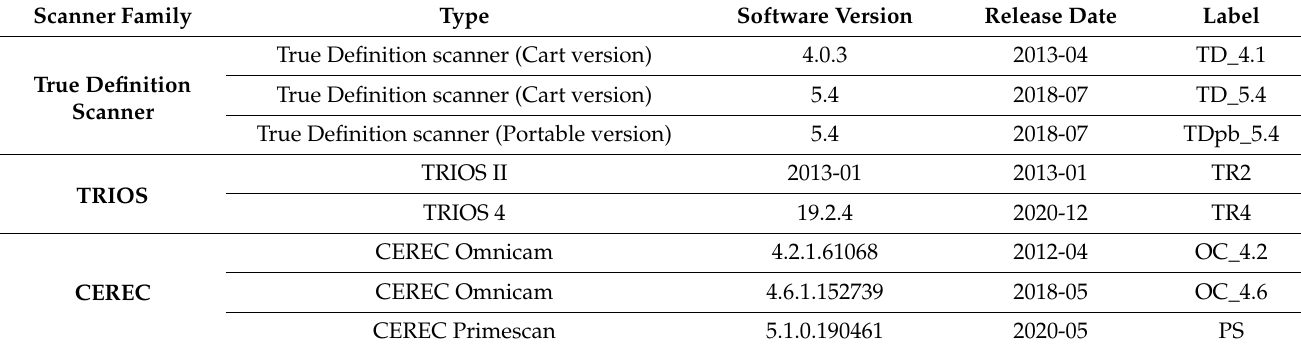
Table 1. Intraoral scanning systems with corresponding software versions used in the present study. Scanner Family